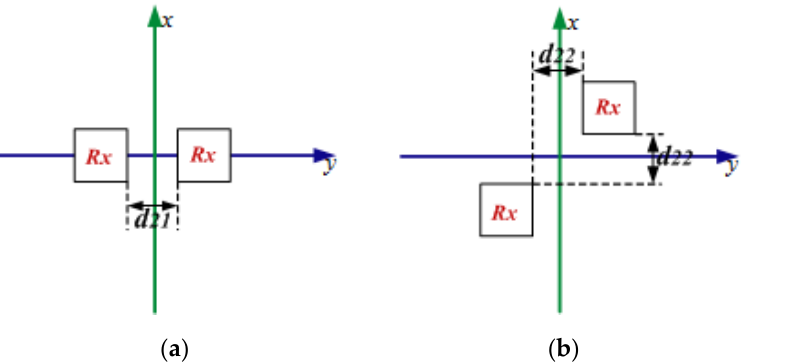
Figure 8. The Rx coils in different topology positions of the STTWR WPT system: ( a ) case 3 and ( b ) case 4.